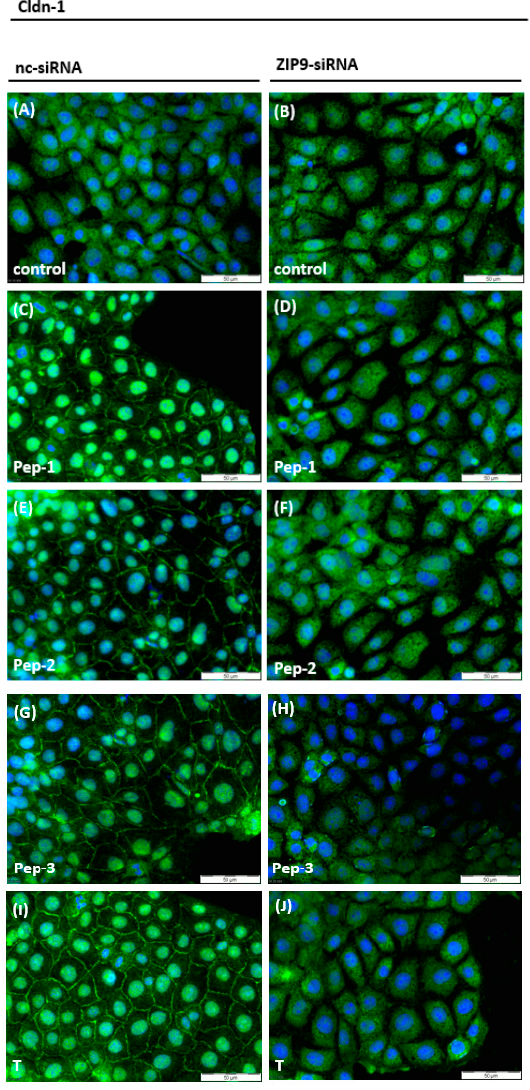
Figure 8. Detection of Claudin-1 in Sertoli cells by immunofluorescence. Nuclei are stained blue, Claudin-1 is represented by green fluorescence. ( A , B ) Control cells without stimulation before and after ZIP9 knock down. Claudin-1 is evenly distributed in the cytosol. ( C , E , G , I ) Cells were treated with nc-siRNA and stimulated with peptides (10 µM) or T (10 nM) for 24 h. Claudin-1 is visible within the nuclei and also in plasma membranes. ( D , F , H , J ) show 93RS2 cells treated with ZIP9-siRNA before exposure to peptides or T. Claudin-1 is evenly distributed within the